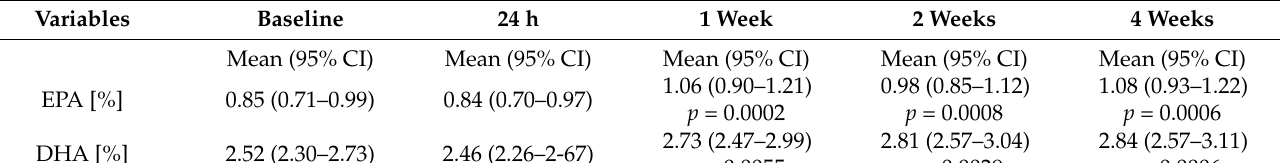
Figure 4. Fatty fish consumption vs. n -3 PUFA index at screening, scatter plot with mean ± 95% CI, * p < 0.05.